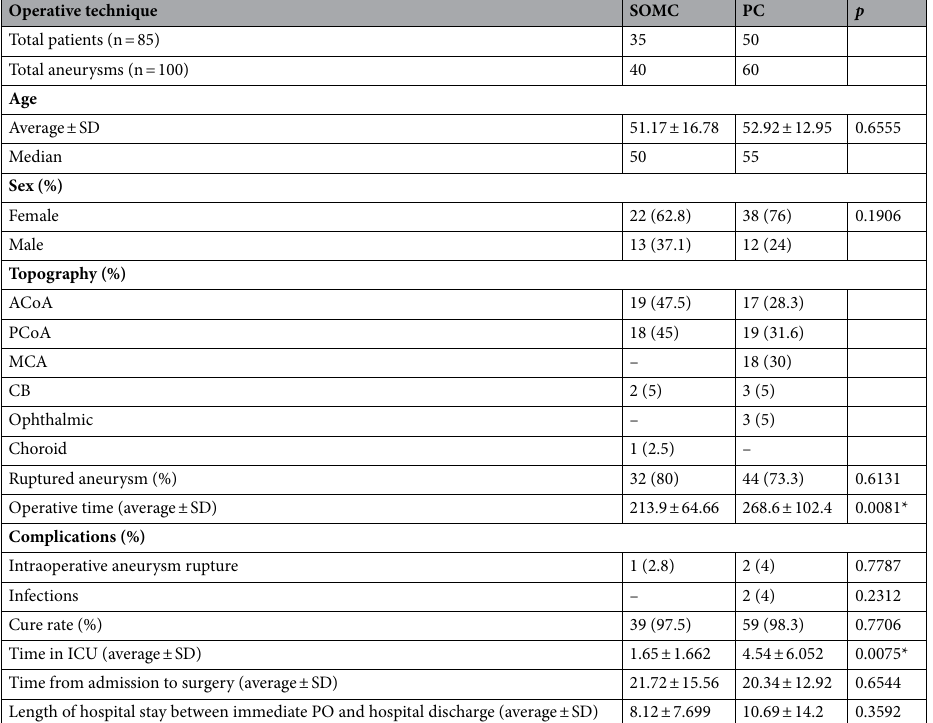
Table 1. Demographic, angiographic, surgical, and clinical characteristics of patients who underwent supraorbital minicraniotomy (SOMC) with eyebrow incision and conventional pterional craniotomy (PC). ACoA anterior communicating artery, CB carotid bifurcation, MCA middle cerebral artery, ICU intensive care unit, PCoA posterior communicating artery, PO postoperative period, SD standard deviation. *Significant. Unpaired Student’s t test and chi-squared